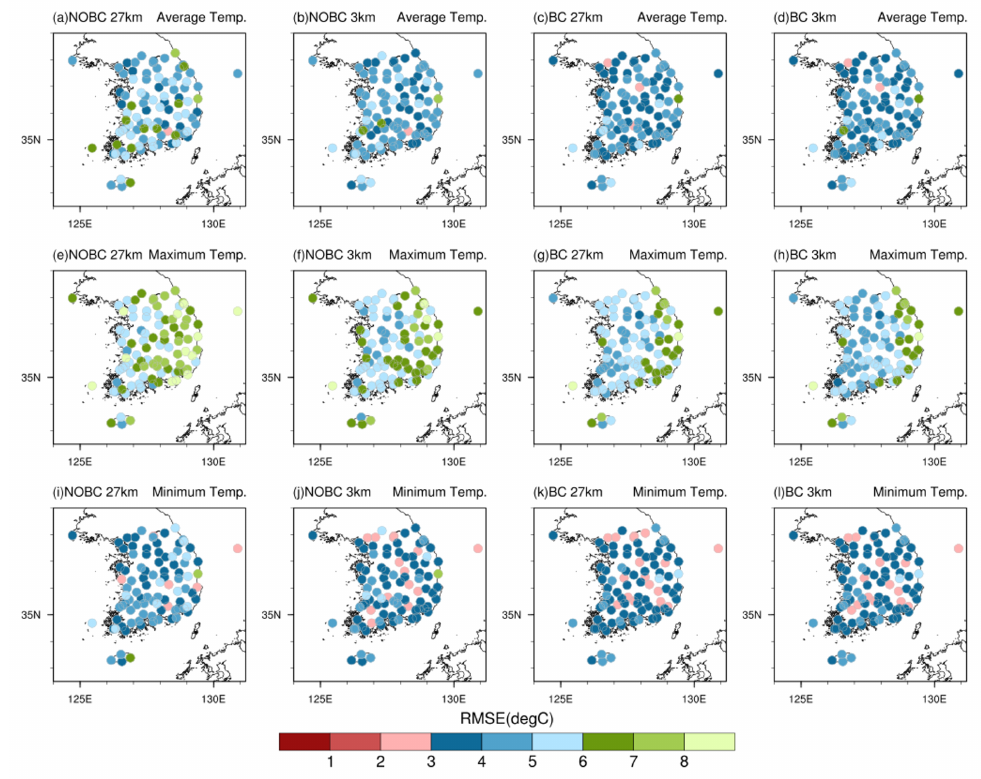
Figure 10. The spatial distribution of the RMSE of the WRF simulation, initialized at 1800 UTC on 15 June (CASE 1), at 94 stations over South Korea. ( a – d ): RMSE for daily average temperature; ( e – h ): RMSE for maximum temperature; ( i – l ): RMSE for minimum temperature. ‘BC’ and ‘NOBC’ denote the WRF simulation using bias-corrected boundary conditions and non-biased conditions,